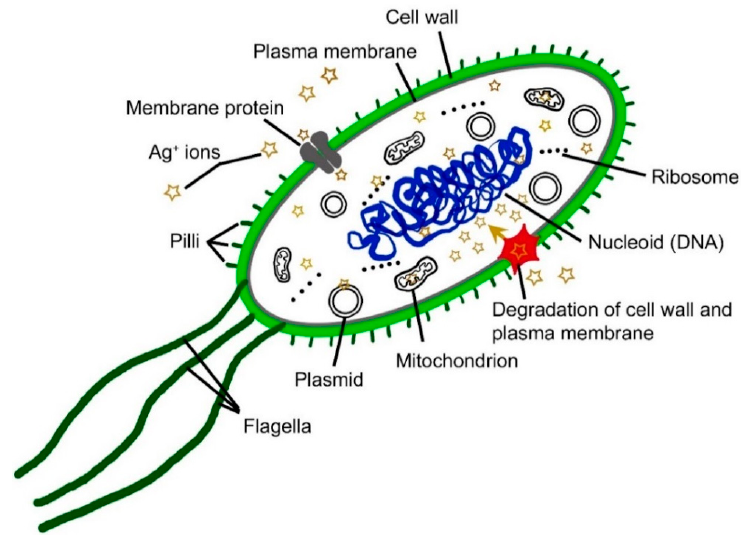
Figure 5. Multifaceted mechanisms of the antibacterial action of silver ions.